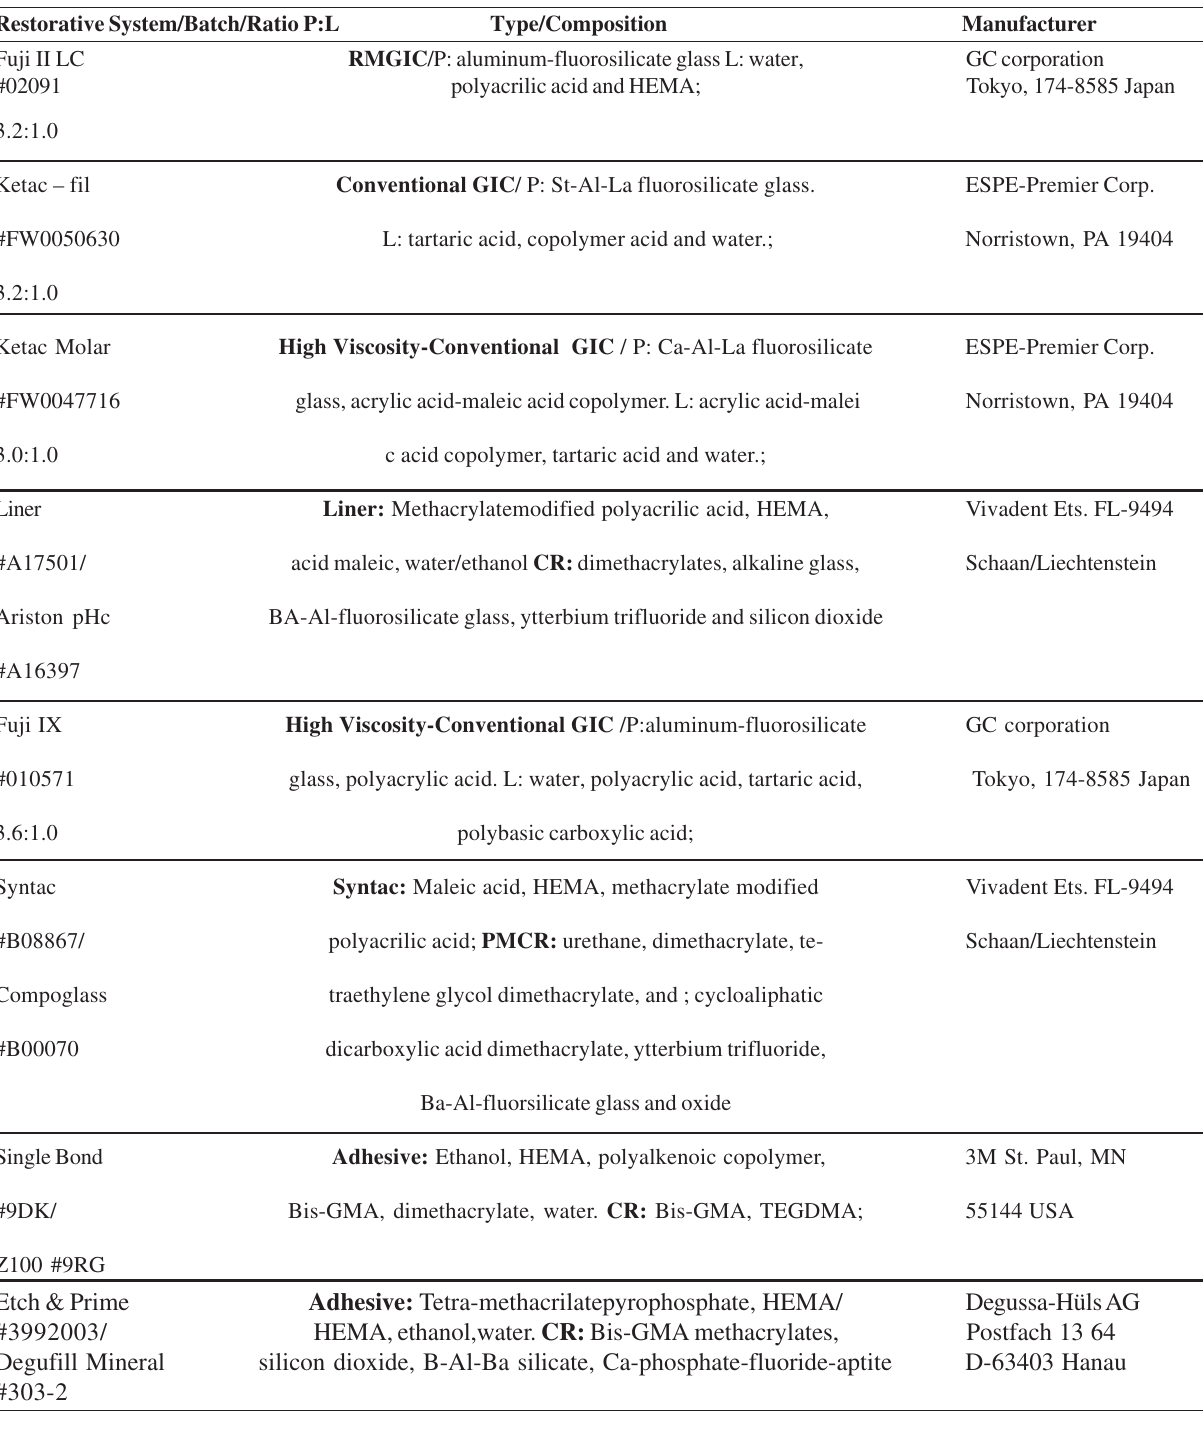
Table 1. Specification, composition and manufacturers of the tested